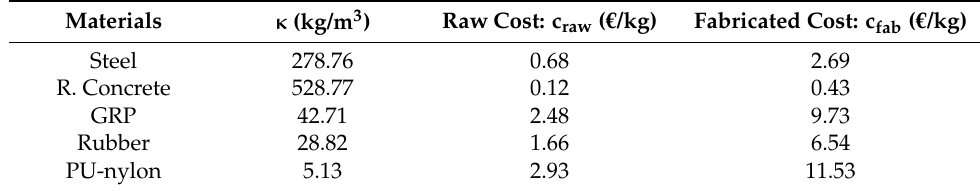
Table 6. Values used in the tool for κ (approximation of the density of the overall hull), raw material costs per mass and fabricated cost per mass for the five materials: steel, reinforced concrete, GRP, rubber and